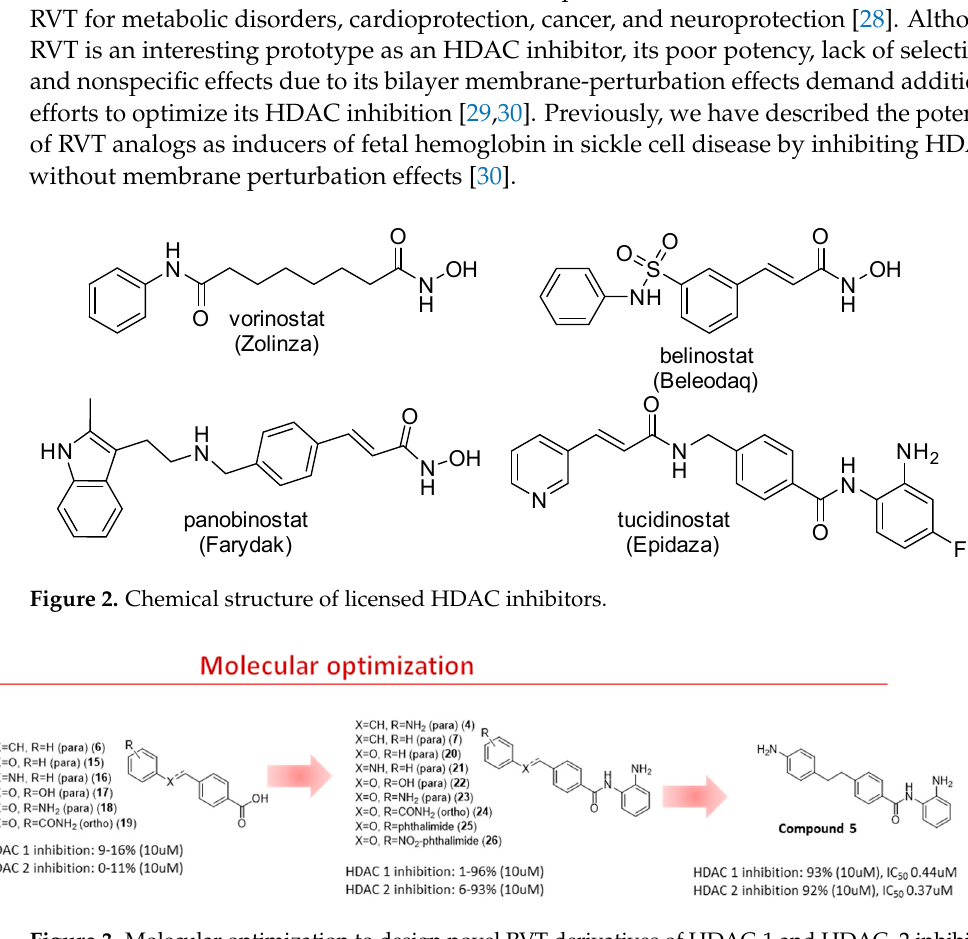
Figure 2. Chemical structure of licensed HDAC inhibitors.